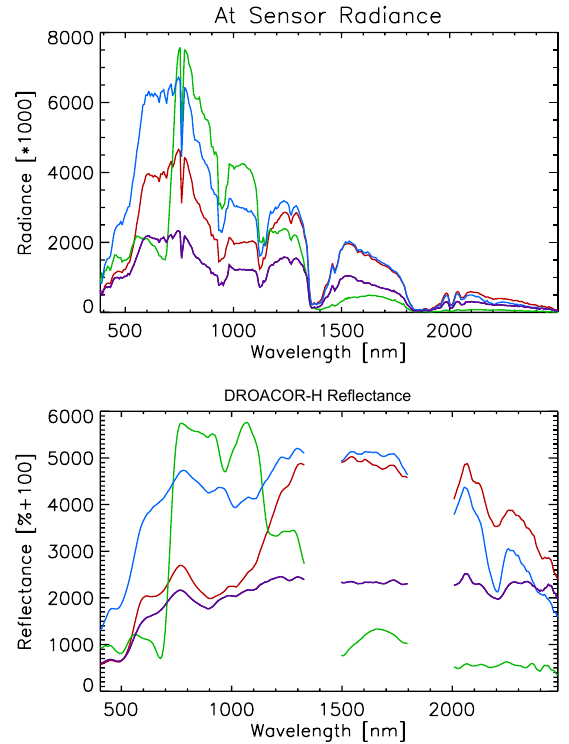
Figure 4. Spectra taken from sample image, before and after DROACOR-H processing: one vegetation spectrum (green) in comparison to three mine face mineral